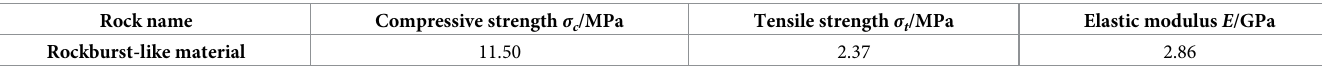
Table 5. Similar mechanical parameters of